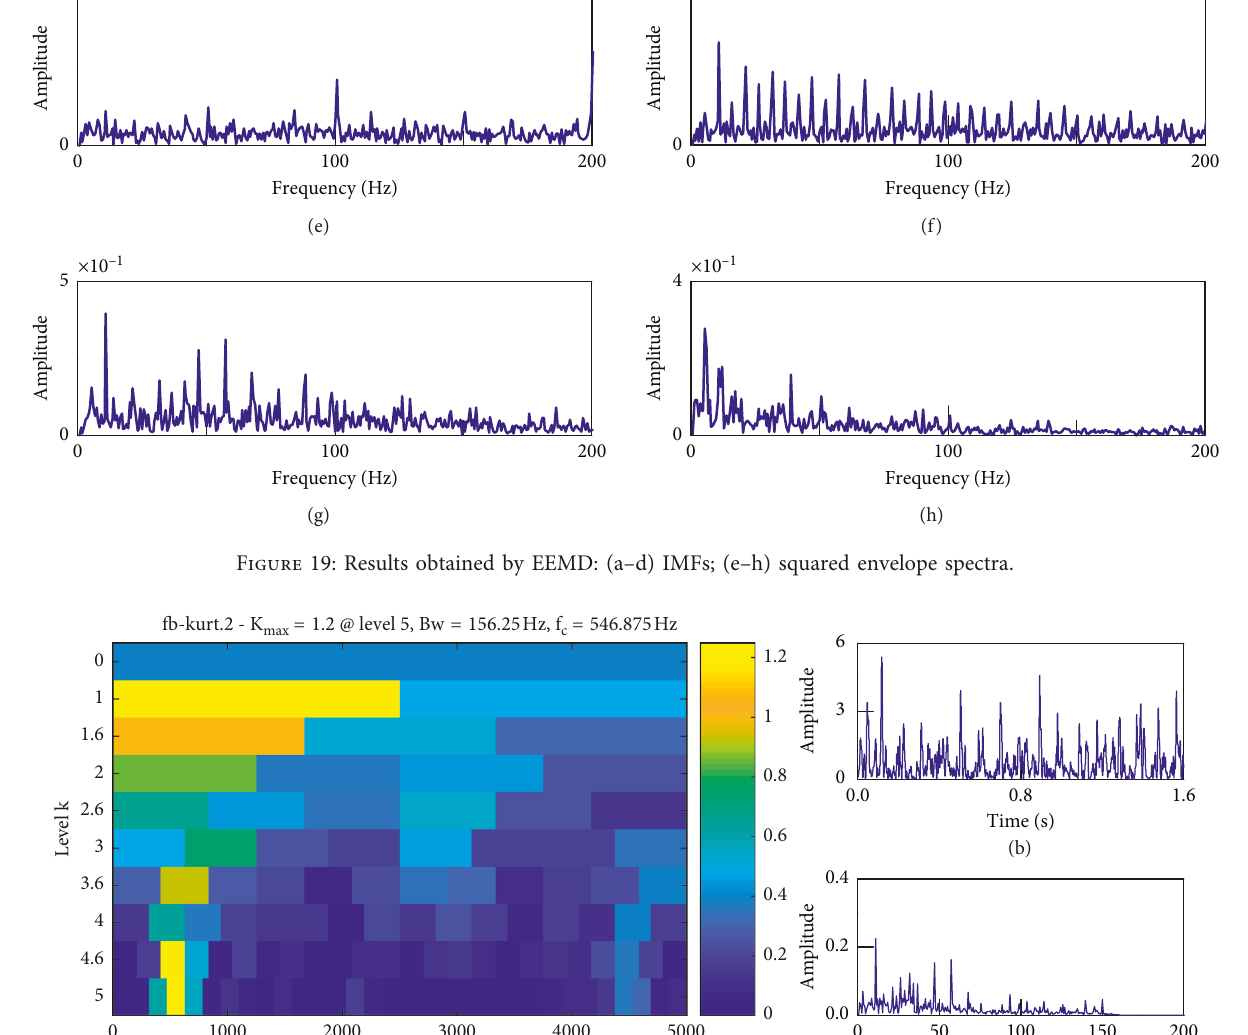
Figure 20: Results obtained by the fast kurtogram: (a) kurtogram; (b) squared envelope of the node with the largest kurtosis value; (c) squared envelope spectrum of